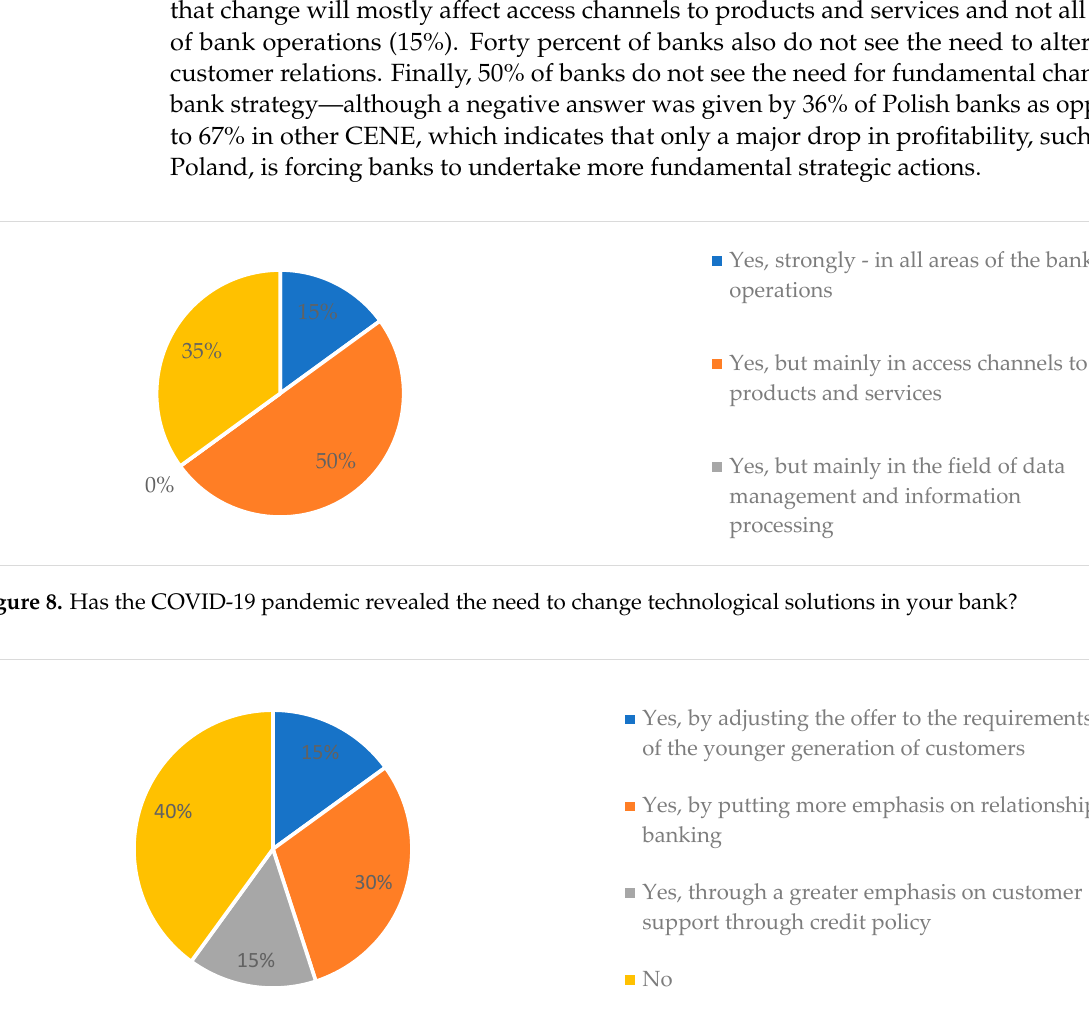
Figure 9. Has the COVID-19 pandemic revealed the need to change customer relations in your bank?